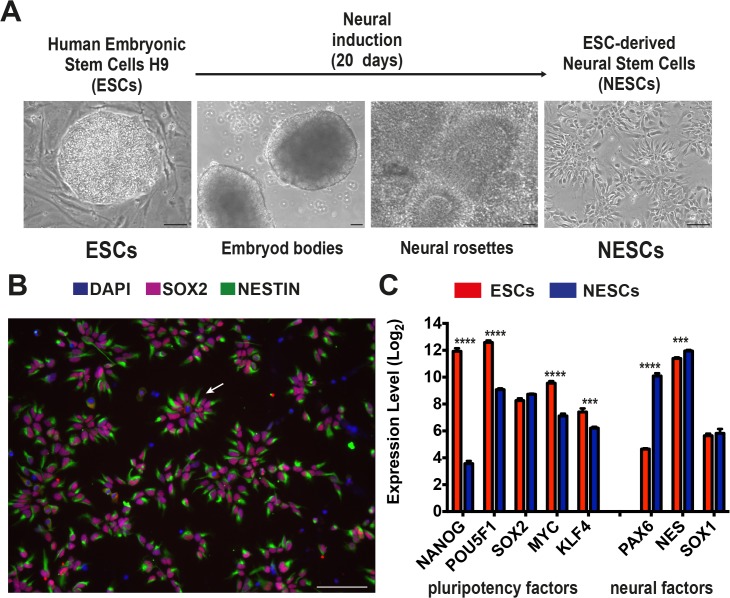
Neural induction of human ESCs to NESCs.A) Schematic representation of the protocol used to differentiate the ESC line H9 to NESCs, entailing the formation of embryoid bodies, followed by neural rosette formation and mechanical isolation. Bar scale 100 μm. B) NESCs cultured in EGF and FGF2 containing medium staining positive for SOX2 in the nucleus (red) and NESTIN in the cytoplasm (green), bar scale 100 μm. NESCs showed a tendency to distribute in rosettes-like structures (white arrow), with the nuclei located at the center and the cytoplasms at the periphery. C) Expression level of pluripotency and neural factors in the three independent cultures of ESCs and NESCs as obtained from the microarray analysis. Genes marked by asterisks were significantly differentially expressed (p ≤0.001***, p ≤0.0001 ****, unpaired t test with Bonferroni correction).